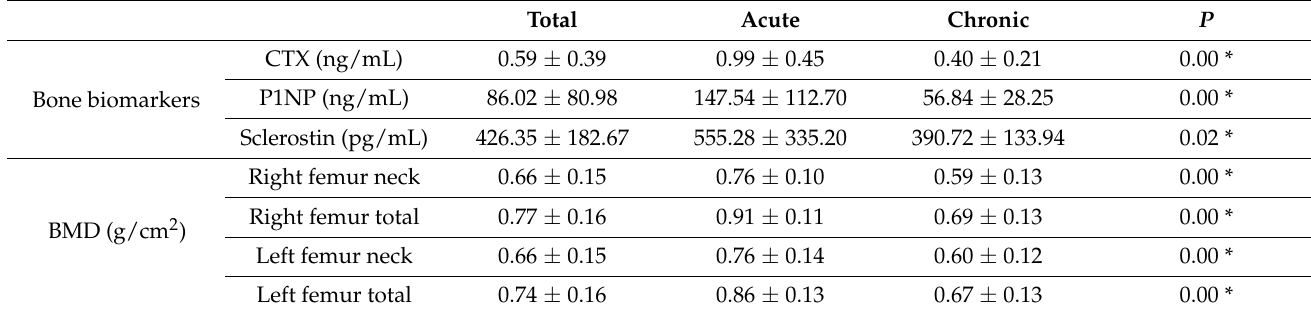
Table 3. Bone biomarker levels and bone mineral